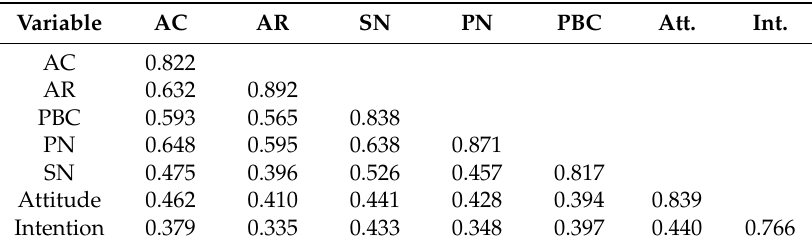
Table 3. Correlation of Constructs and